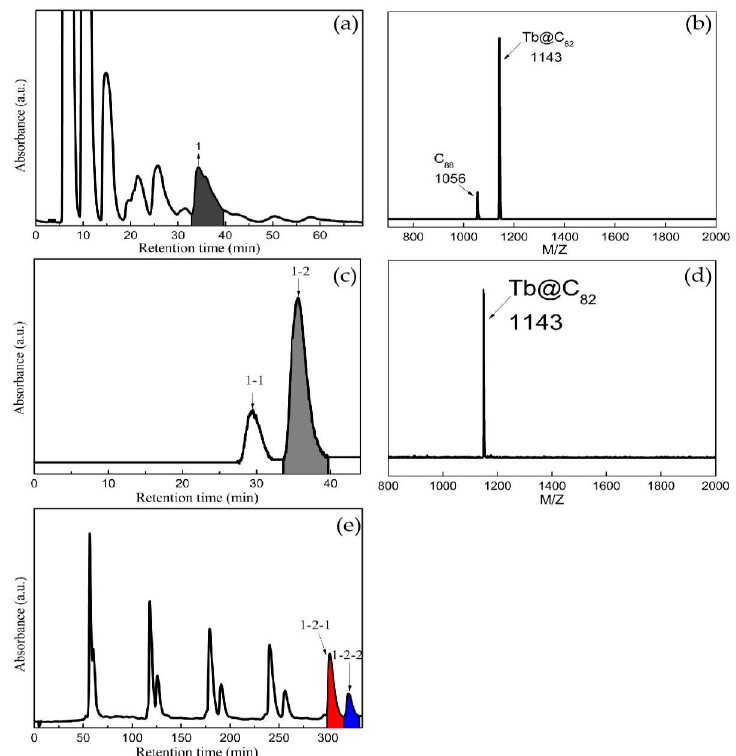
Figure 1. The ( a ) first, ( c ) second and ( e ) third stages of HPLC isolation of Tb@C 82 (I, II) isomers (column size: Ф20 mm × 250 mm; injection volume: 20 mL; eluent: toluene with a flow rate of 10 mL/min; detection wavelength: 290 nm at 298 K). The MALDI-TOF mass spectra of ( b ) fraction 1 and ( d ) fraction 1-2.